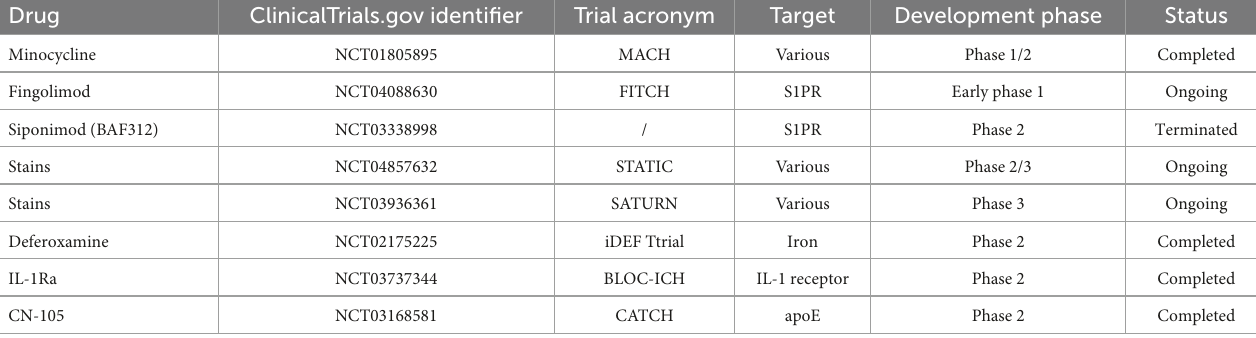
TABLE 2 Current and potential clinical medicine for intracerebral hemorrhage (ICH).